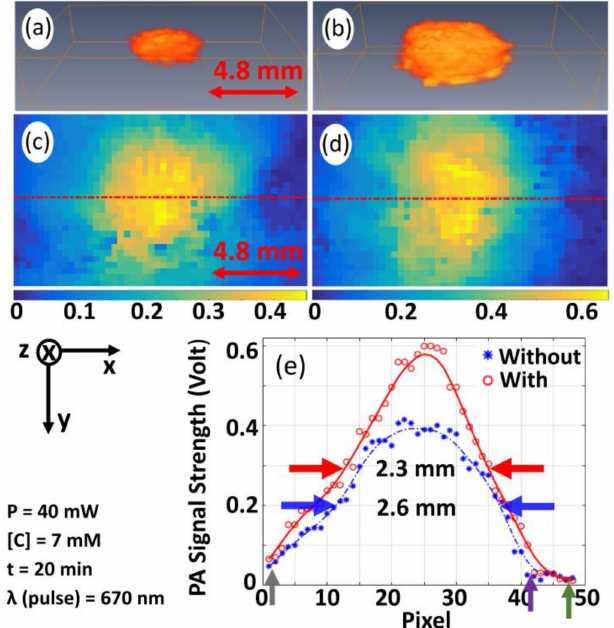
Figure 3. 3D image representatives of P 0 without ( a ) and with ( b ) pre-illumination for methylene blue while 2D image corresponding to a randomly selected plane (at z = 7) (( c ), without pre-illumination and ( d ), with pre-illumination). ( e ) Variation of P 0 along the marked lines depicted in ( c , d ). Arrow- heads in both sides of scale bar (being included in ( a , c )) indicate measure of the entire length of the image along x -axis. Arrowheads, marked in ( e ), indicate the points of observations for estimation of size of the illuminated